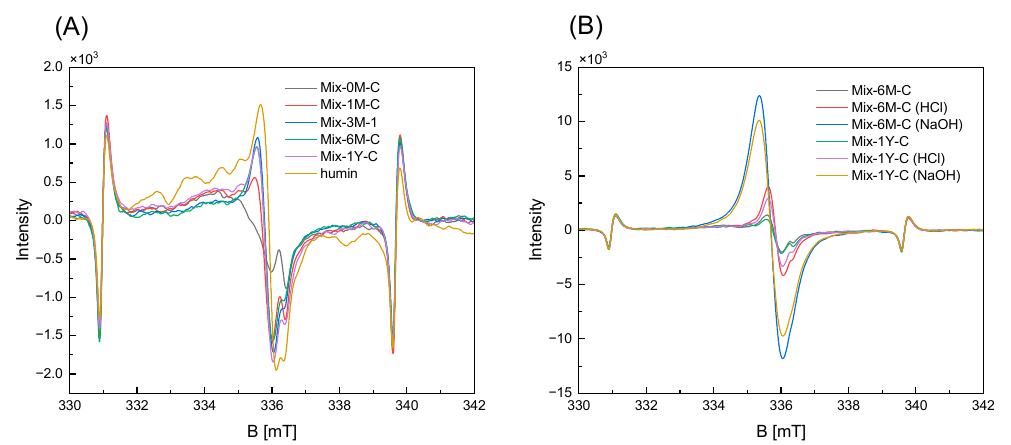
Figure 4. ( A ): The ESR spectra of rice straw ‐ artificial soil mixtures with 0, 1, 3, 6 months, or 1 year of humification (Mix ‐ 0M ‐ C, Mix ‐ 1M ‐ C, Mix ‐ 3M ‐ 1, Mix ‐ 6M ‐ C, and Mix ‐ 1Y ‐ C), and of humin, with the 3rd and 4th Mn marker signals. The measurement was carried out using the composite samples except for Mix ‐ 3M ‐ 1. ( B ): The ESR spectra of rice straw ‐ artificial soil mixtures with 6 months and 1 year of humification (Mix ‐ 6M ‐ C, Mix ‐ 1Y ‐ C) and Mix ‐ 6M ‐ C and Mix ‐ 1Y ‐ C treated with 0.1 M HCl or 0.1 M NaOH, respectively, with the 3rd and 4th Mn marker signals. The measurement was carried out using the composite samples. 3.4. Changes in Electrochemical Properties during the Humification The CVs demonstrated that the Mix sample was not initially redox ‐ active, but con ‐ verted to redox ‐ active during humification (Figure 5). Currents of less than 3 μ A were detected in the CVs of rice straw and Mix ‐ 0M ‐ C (Figure S14). After three months of humi ‐ fication, the CVs showed larger currents to the applied voltage and overall slope, espe ‐ cially when applied negative potential. However, no specific redox peaks were identified for any of the Mix samples. This suggested an increase in the redox ‐ active moieties in the samples. Figure 5. Cyclic voltammograms (CVs) of rice straw ‐ artificial soil mixtures with 0, 1, 3, 6 months, and 1 year of humification (Mix ‐ 0M ‐ C, Mix ‐ 1M ‐ C, Mix ‐ 3M ‐ 1, Mix ‐ 6M ‐ C, and Mix ‐ 1Y ‐ C). All CVs presented here were obtained at the 10th cycle of the measurement. The measurement was carried out using the composite samples except for Mix ‐ 3M ‐ 1. EIS measurements were performed under the same conditions as the cyclic voltam ‐ metry measurements to obtain the electric capacitance of Mix samples. Using the EIS